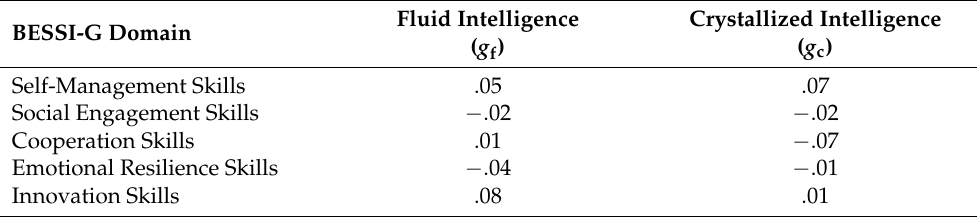
Table 9. Correlations of the BESSI-G domains with cognitive ability (Study